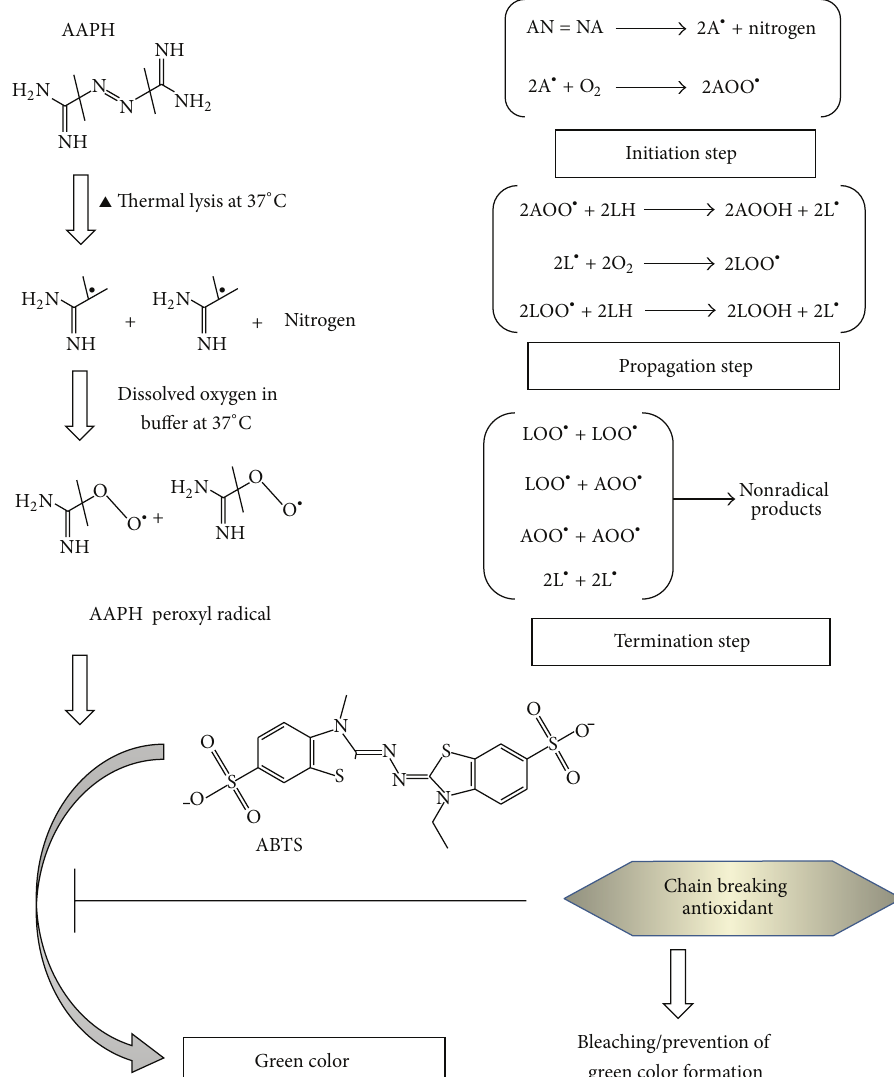
Figure 1: Decomposition of AAPH/ABAP and formation of Peroxyl radicals.